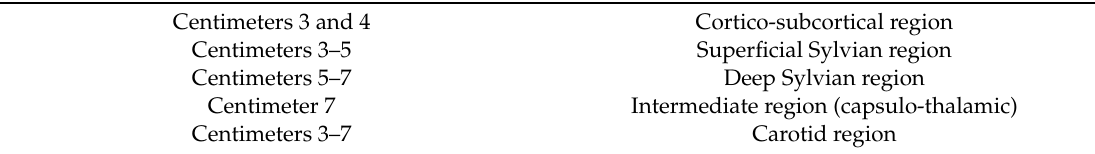
Table 1. The di ff erent individualized regions in each of the temporal lobes from surface to depth and their clustering according to their correspondence with the di ff erent vascular and neurological structures they are associated